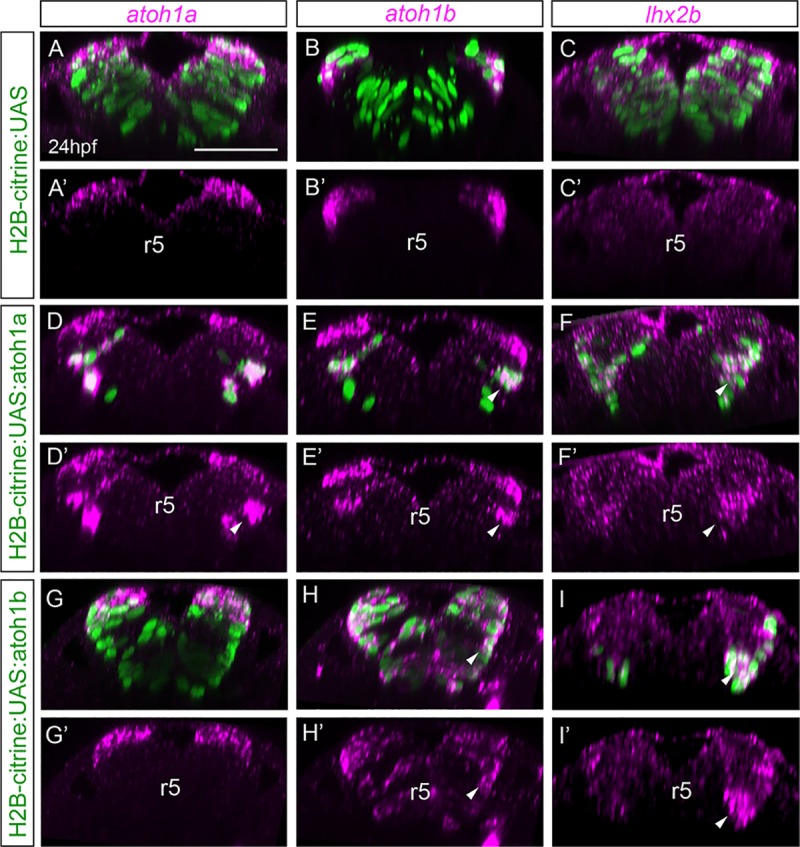
atoh1a is upstream of atoh1b and is necessary for lhxb2 neurons.Mu4127 embryos expressing Gal4 in rhombomeres 3 and 5 were injected with H2B-citrine:UAS (A-C), H2B-citrine:UAS:atoh1a (D-F) or H2B-citrine:UAS:atoh1b (G-I) constructs in order to ectopically express the gene of interest in r3 and r5. Injected embryos were assayed for Citrine expression (green) and atoh1a (A-A’, D-D’, G-G’), atoh1b (B-B’, E-E’, H-H’) or lhx2b (C-C’, F-F’, I-I’) expression (magenta). Reconstructed transverse views displaying the merge of the red and green channels (A-I), or only the red channel (A’-I’). Note that ectopic expression of atoh1a in more ventral domains induces atoh1b and lhxb2 expression (see white arrowheads in D-F, D’-F’), whereas ectopic atoh1b expression induces lhx2b but not atoh1a (see white arrowheads in H-I, H’-I’). See Table 3 for numbers of analyzed embryos. r, rhombomere. Scale bars correspond to 50 μm.